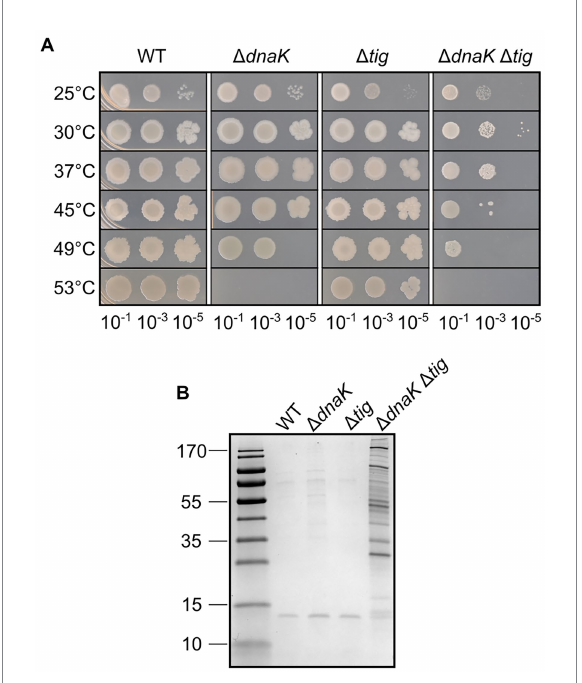
FIGURE 1 Heat tolerance and protein aggregation upon deletion of dnaK and tig . (A) Spot dilution assay for B. subtilis wild-type (1A1), Δ dnaK (LUW876), Δ tig (LUW901) and Δ dnaK Δ tig (LUW878) grown in liquid media at different temperatures. Serial dilutions of the indicated strains were spotted on TBAB. A 10 − 7 dilution was also spotted but not shown, since none of the strains grew. Plates were incubated at the indicated temperatures for 24 h. (B) Protein aggregates in the indicated strains grown at 30 ° C. Proteins were separated by SDS-PAGE and the gel stained with Coomassie blue. Molecular mass markers (10, 15, 25, 35, 40, 55, 70, 100, 130, and 170 kDa) are shown in the left